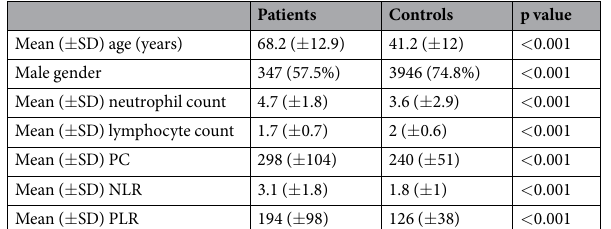
Table 1. NLR, PLR and PC of the 603 patients under study and of the 5270 blood donors cases of the control group.